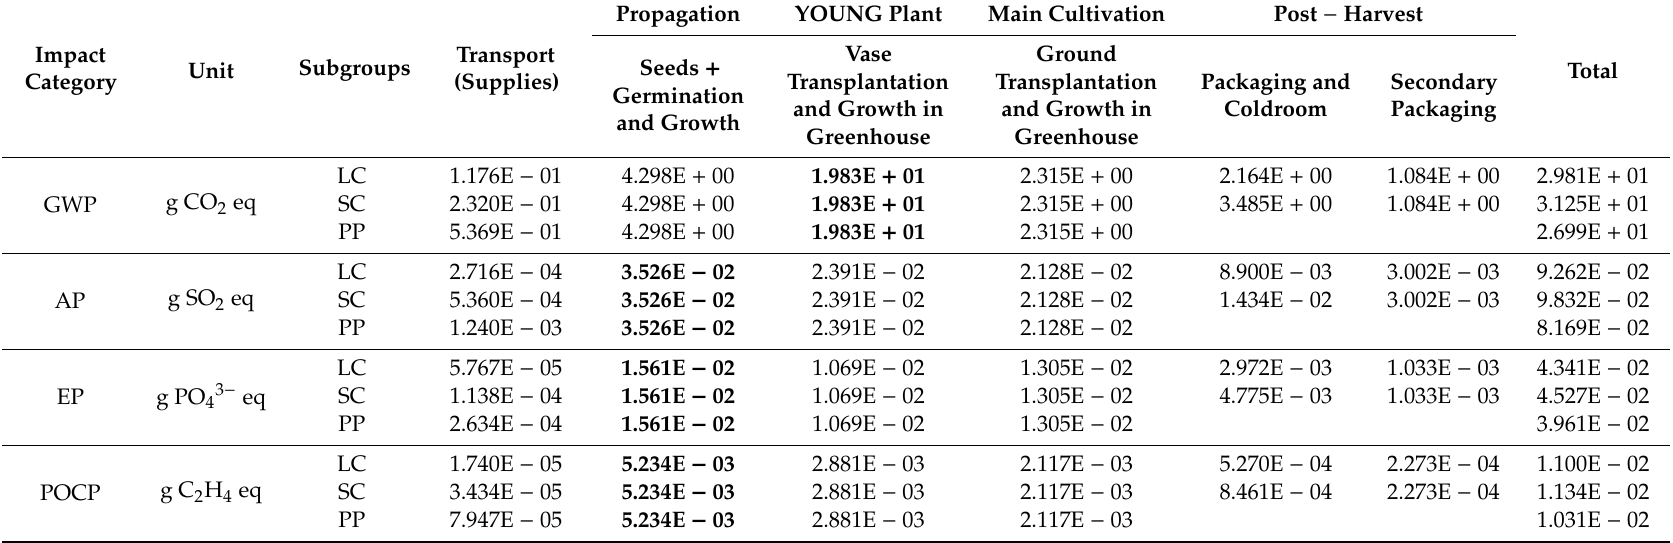
Top contribution are highlighted in